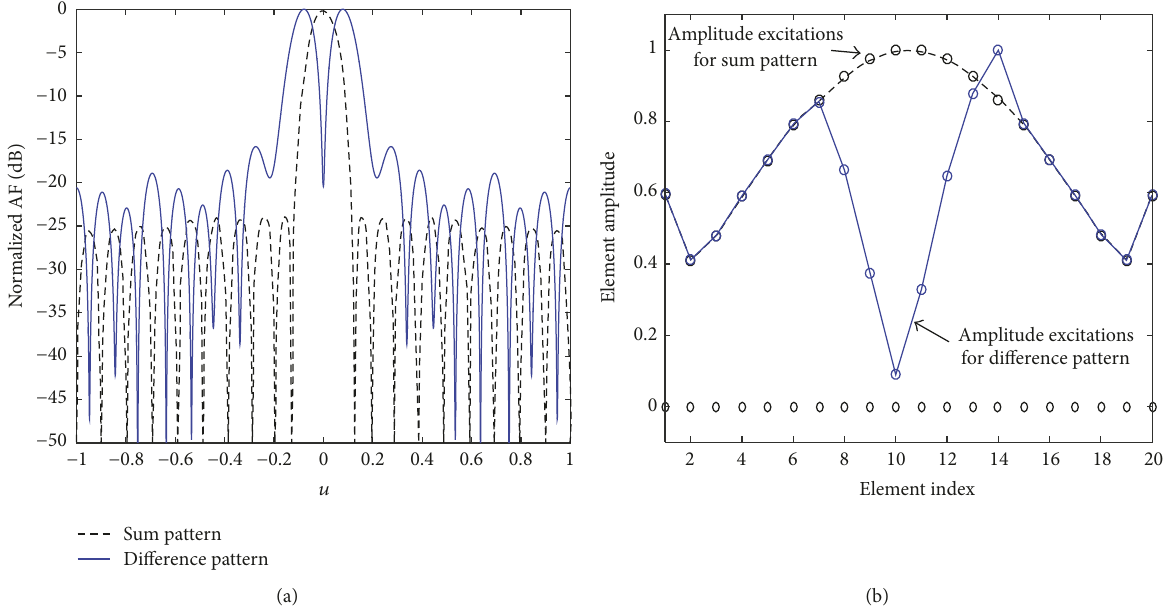
Figure 3: Sum and difference patterns (a) and the corresponding amplitude excitation (b) for the case of fixed sum pattern, 60% common excitation, and 𝑁 = 20